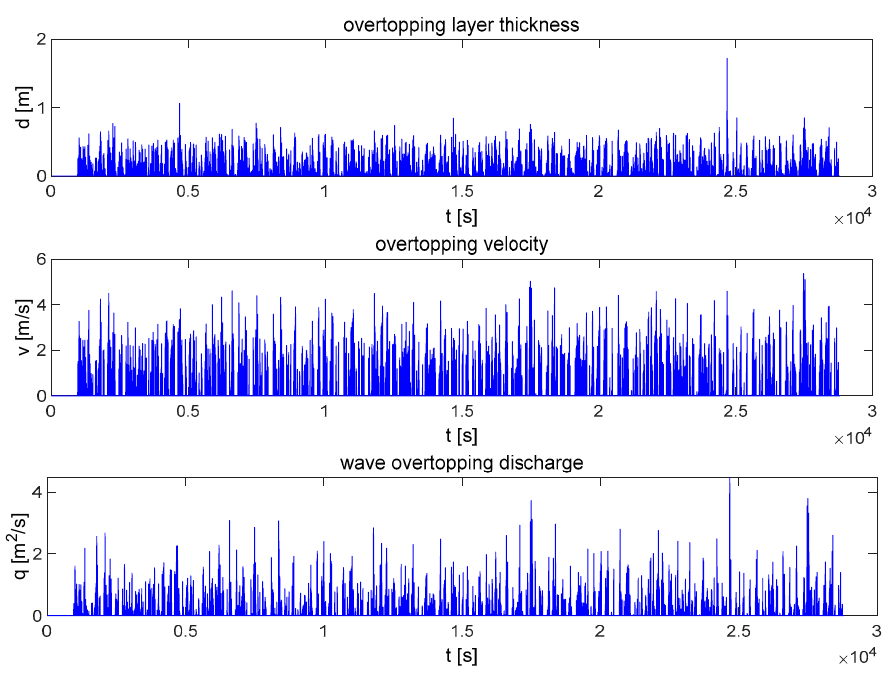
Figure 10. Water thicknesses, velocities, and discharges for the infinite slope.